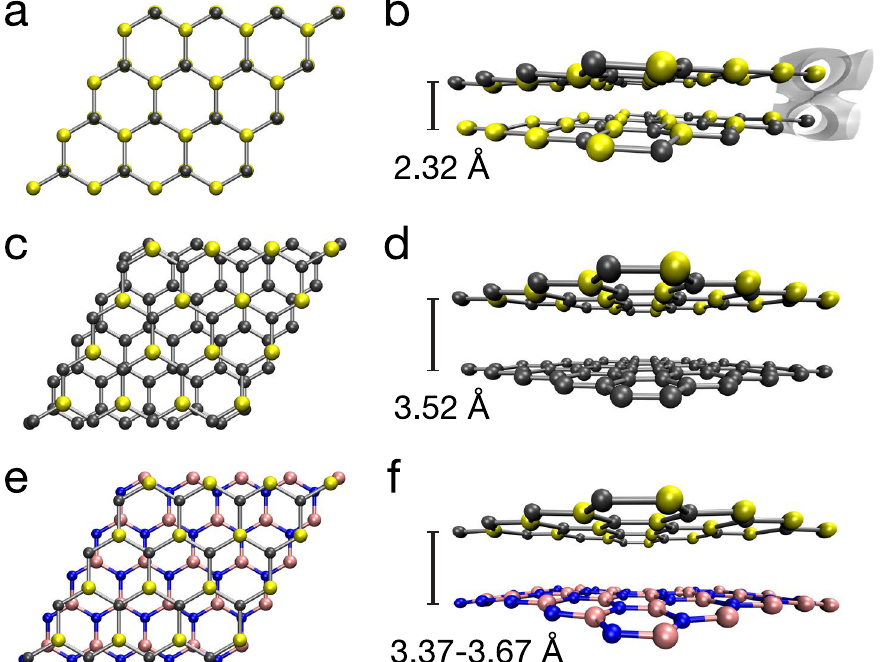
Figure 5. Calculated equilibrium structures of bilayers of 2D-SiC with itself ( a , b ), graphene ( c , d ) and hexagonal boron nitride (hBN, ( e , f )). ( a , b ) Two layers of 2D-SiC in AA’ stacking spontaneously bond covalently (all-electron charge density isosurface shown in the corner of the cell in ( b) ), resulting in an interlayer distance of 2.32 Å. When the other layer is graphene ( c , d ) or hBN ( e , f ), the equilibrium distances and binding energies are typical for van der Waals bonding. (Note that the resulting hBN structure is slightly buckled due to lattice mismatch in the simulation unit